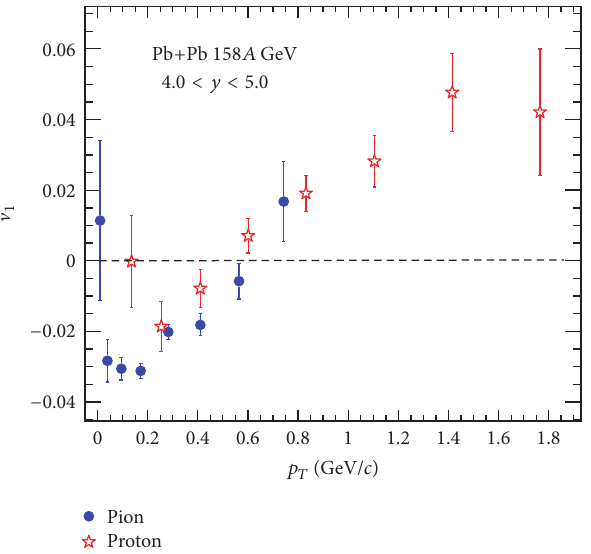
Figure 7: Pion and proton V 1 (𝑝 𝑇 ) at 4 < 𝑦 lab < 5 in Pb+Pb collisions at the SPS, at a projectile kinetic energy of 158 𝐴 GeV